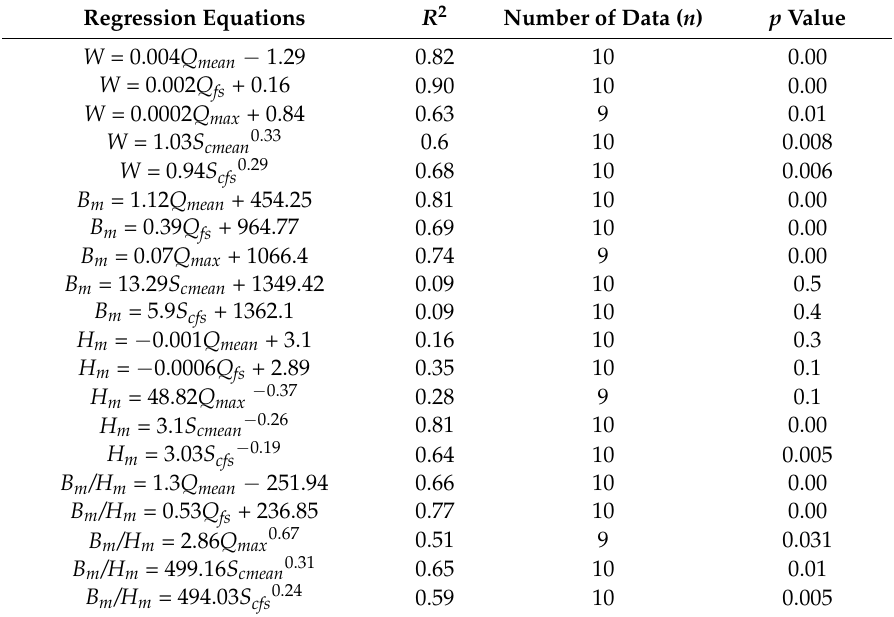
Table 3. Regression equations between morphological indices and water-sediment factors. Regression Equations R 2 Number of Data ( n